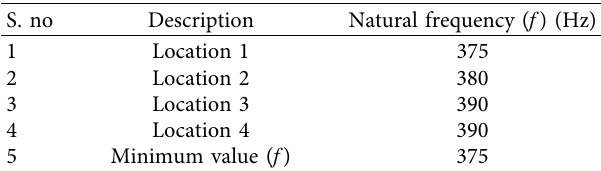
Figure 9: Frequency response of Mg alloy swivel plate under no loading condition. Table 5: Natural frequency for A3 steel (with 4 location points). Table 6: Natural frequency for Mg alloy (with 4 location